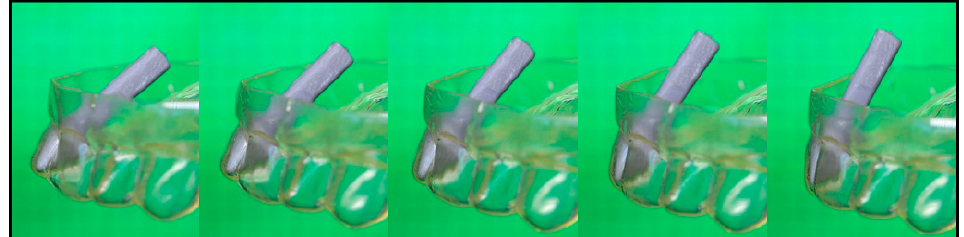
Figure 8. Thermo-responsiveness of a programmed TPU aligner with a misaligned incisor. The pin was inserted to better follow shape recovery on heating from 23 °C (left) to 80 °C (right).